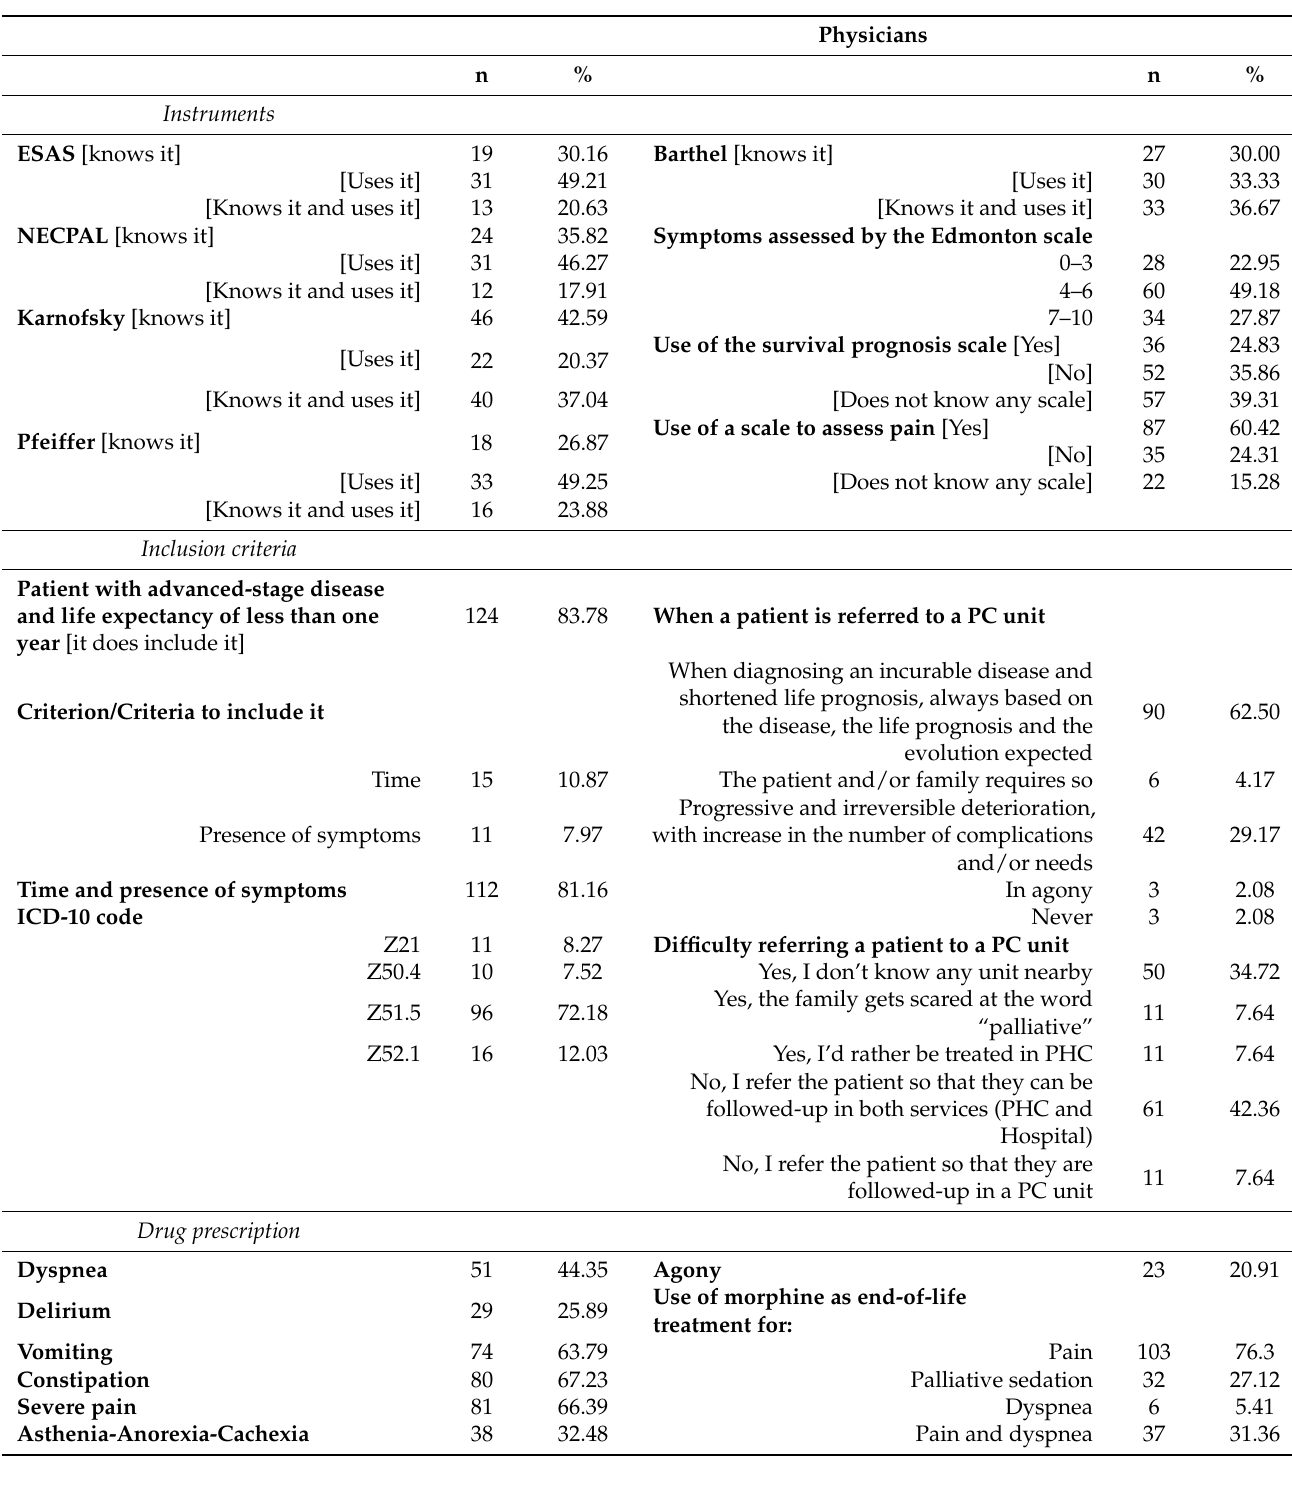
Table 3. Use and knowledge about instruments, inclusion criteria, and prescription in PC by the